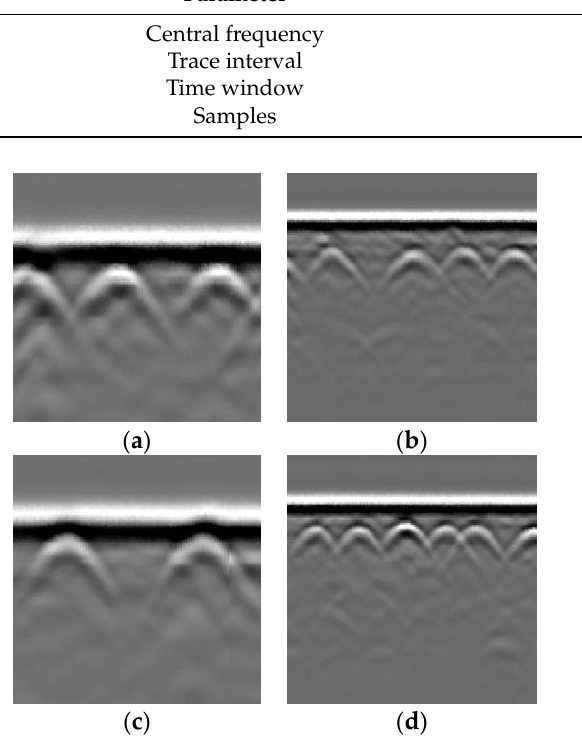
Figure 4. ( a – d ) Examples of field GPR images, in which rebars are easily recognized. Table 3. Parameters for GPR data acquisition.